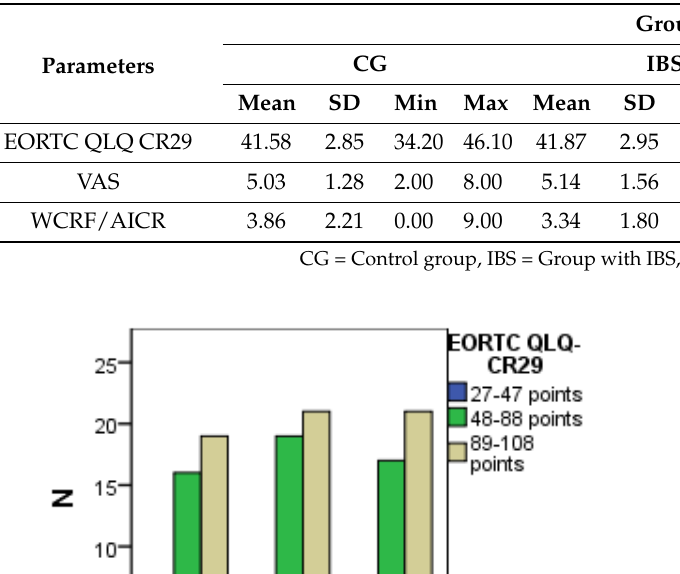
Table 8. Descriptive statistics of the 3 quality of life tests.